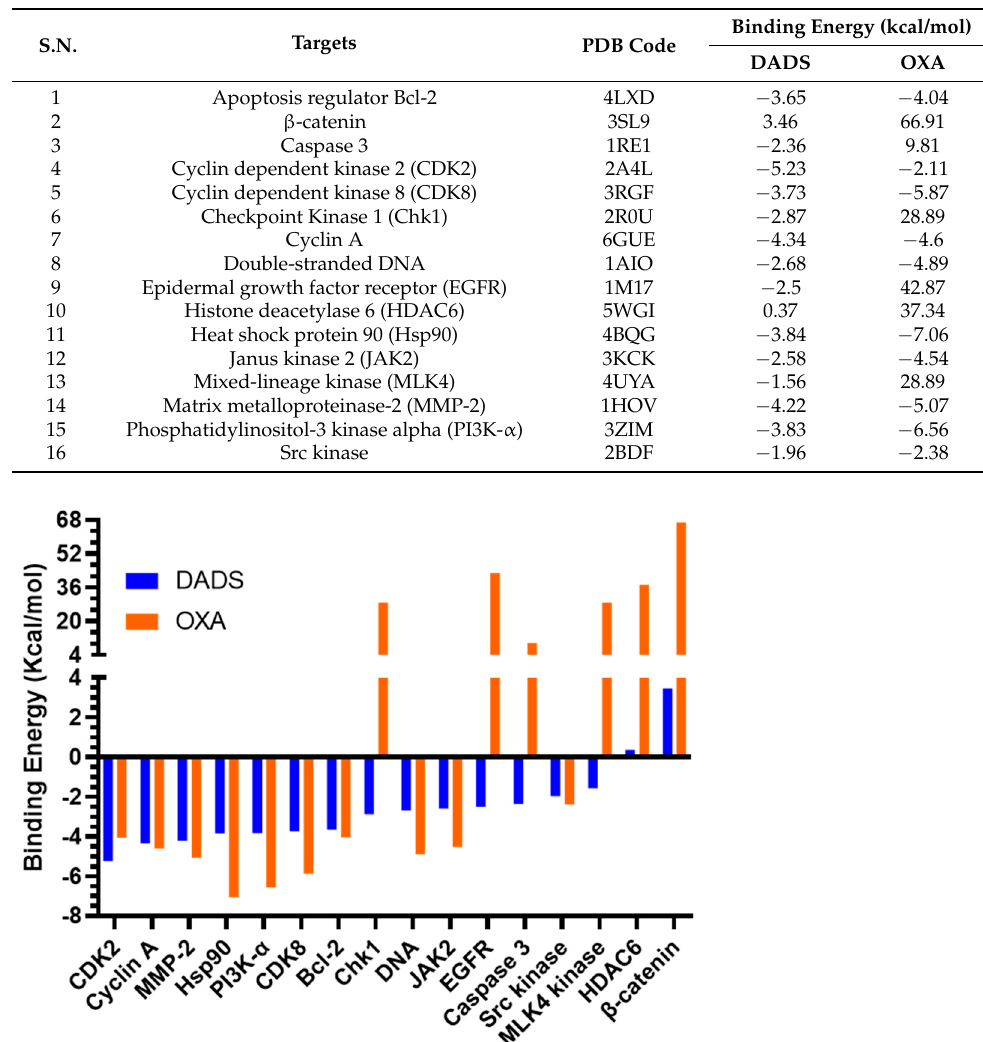
Table 3. Molecular docking of DADS and OXA against several anticancer drug targets.